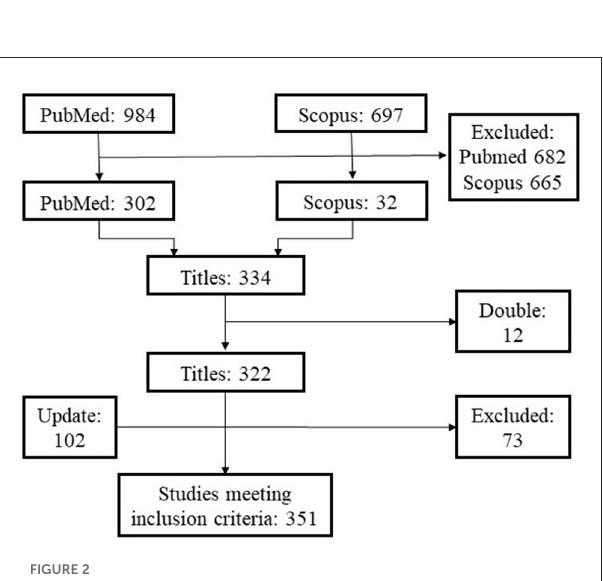
FIGURE2 Search process for identifying publications on feeding and social management strategies in calf